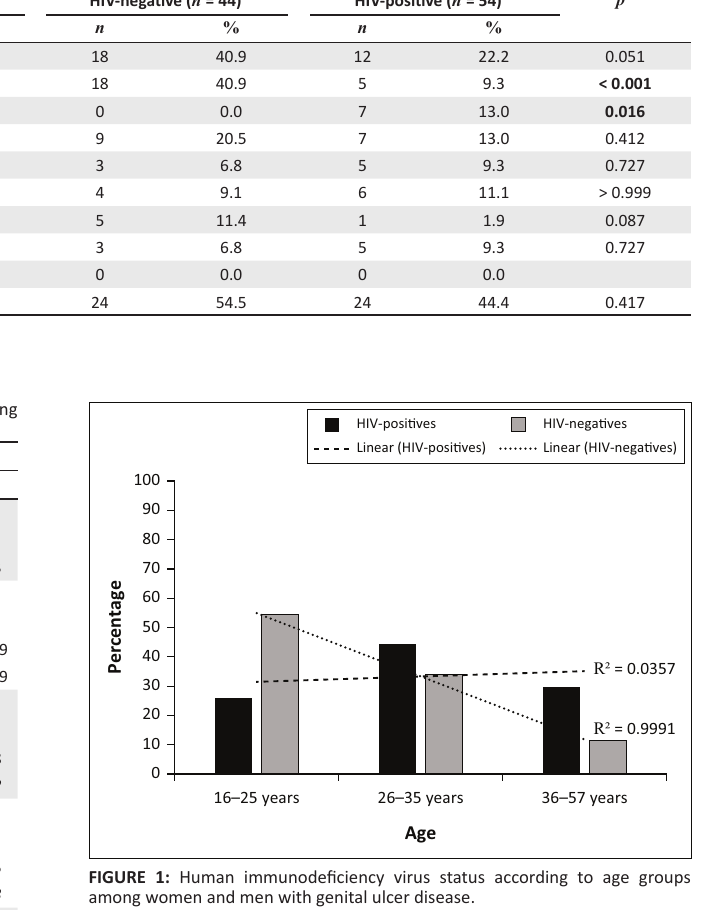
TABLE 3: Prevalence of ulcerating pathogens among public community health centre attendees with Genital ulcer disease . Ulcerating